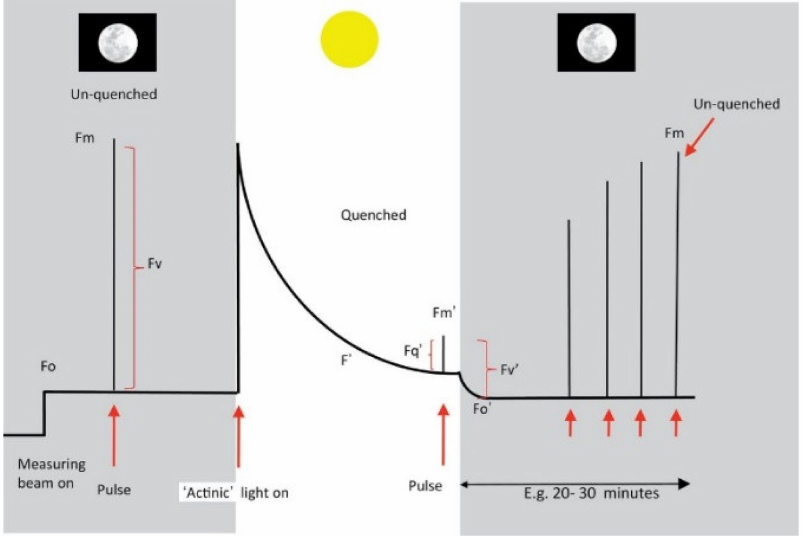
Figure 3. A typical chlorophyll fluorescence kinetic curve used to measure the leaf’s photochemical and non-photochemical parameters. A measuring beam means light that is too low to induce photosynthesis but high enough to elicit chlorophyll fluorescence. Actinic light means light is fit for photosynthetic function. Pulse means saturating flash that can transiently close all PS-II reaction centers, but the flash is short enough, so no increase in non-photochemical quenching occurs. (Reprinted with permission from Ref.